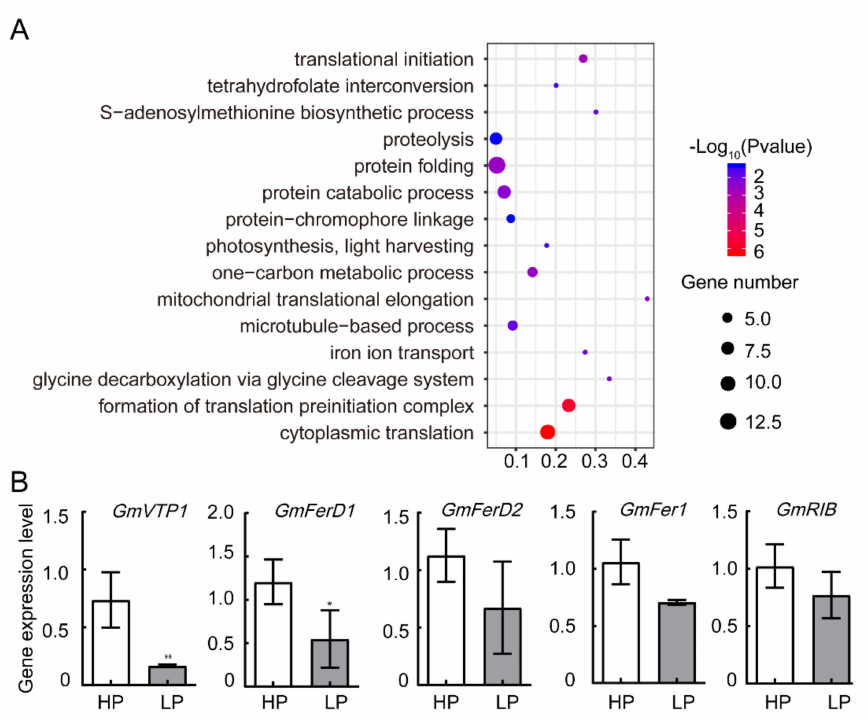
Figure 4. GO and qPCR analysis of LP-reduced proteins. ( A ) Functional categorization of LP-reduced proteins based on biological processes. Bubble colors represent the corrected p -value, and the bubble sizes indicate the number of genes. ( B ) The qPCR analysis of LP-decreased gene identified in LFQ analysis. Error bars: SEM. Asterisks indicate significant differences by Student t-test: * p < 0.05, ** p